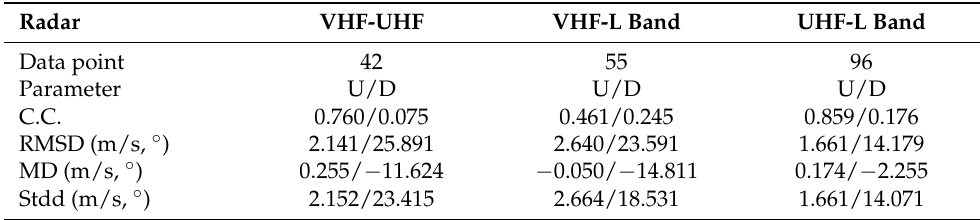
Figure 13. Same as Figure 12, but for horizontal wind velocity ( upper ) and wind direction ( lower ). Table 7. Comparisons of horizontal wind velocity (U) and wind direction (D) between wind profilers in the presence of